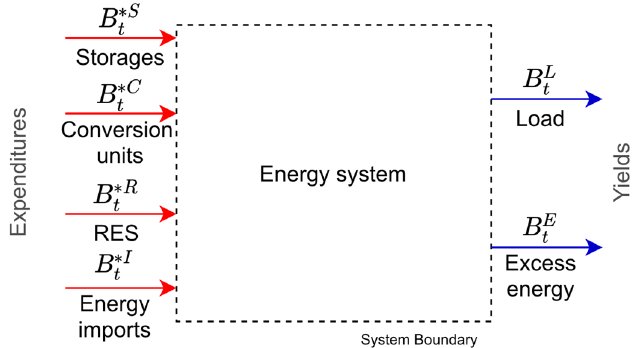
Figure 1. Cumulative exergy consumption (CExC)-expenditures (imports, renewable energy sources (RES), storages and conversion units) and yields (load and excess).